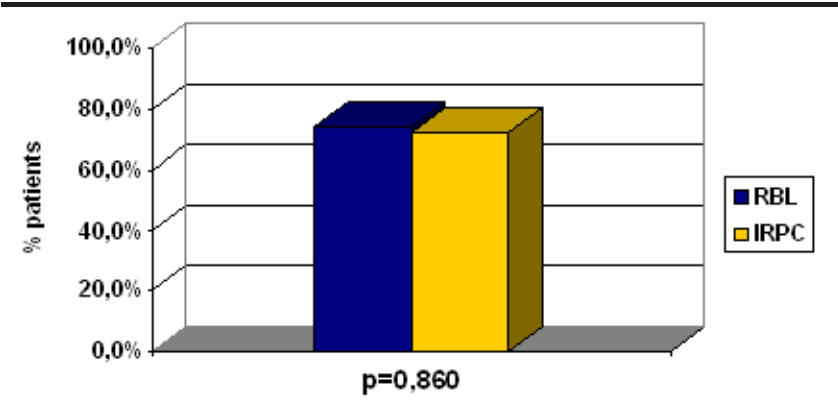
Fifteen (93,7%) patients in group 1 were free of bleeding versus 18 (90,0%) in group 2, difference not significant (p=1,00). In group 1, 14 (87,5%) patients were free of